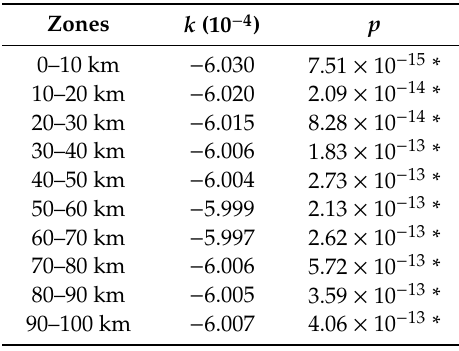
Table 4. Slopes of residual trends and test results.